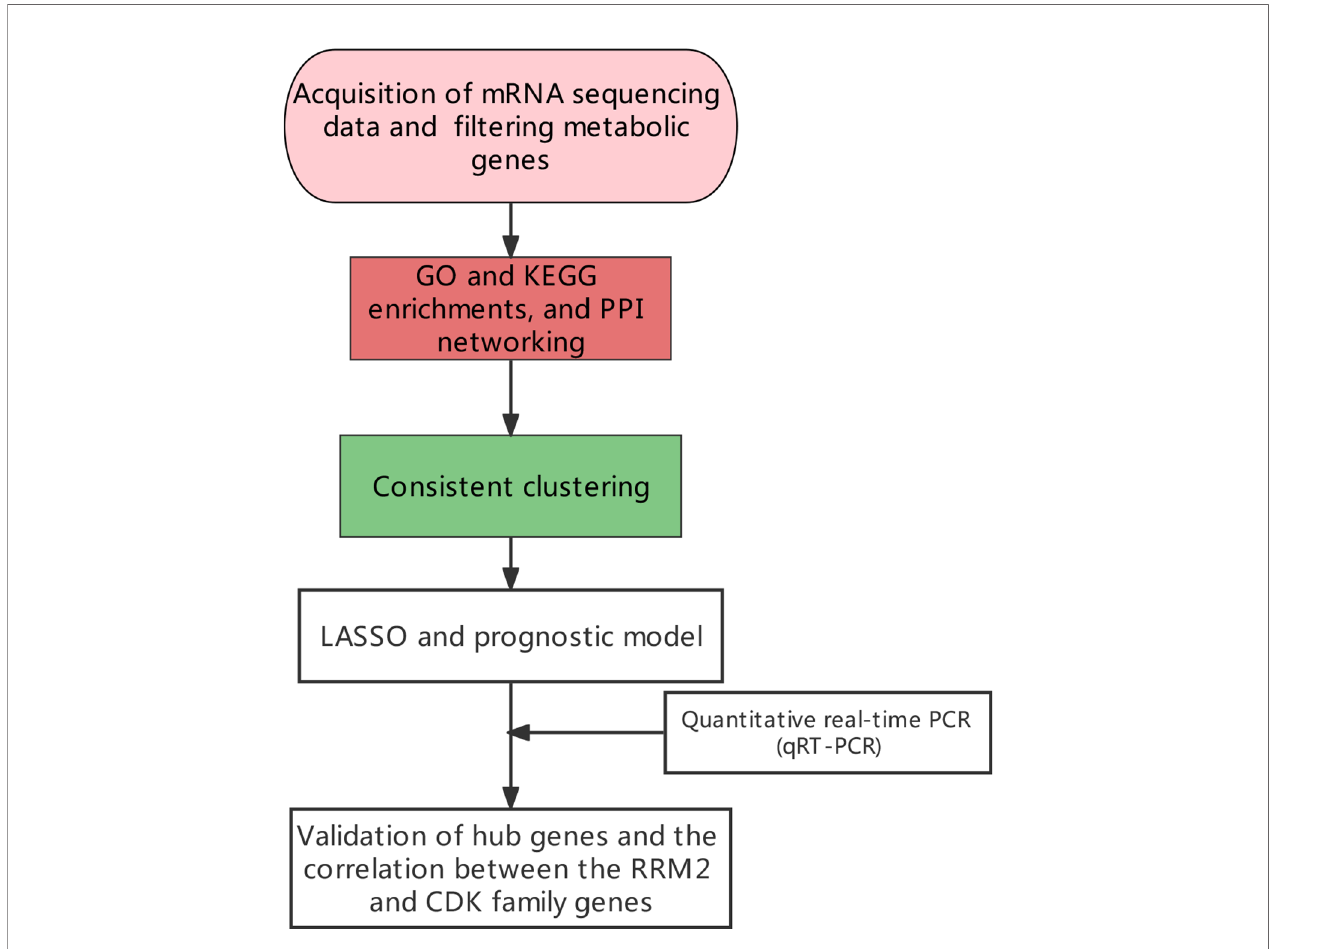
FIGURE 1 | The general research design and fl ow of the